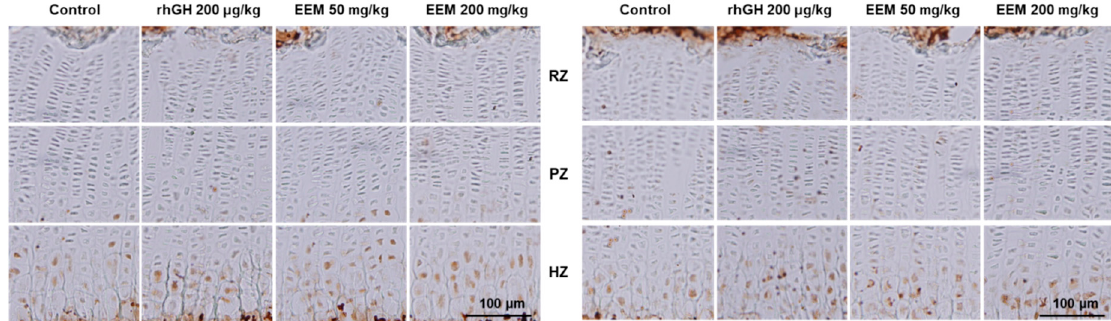
Figure 5. Immunohistochemical localizations of IGF1 and BMP2 on the proximal tibial GP in rats. RZ: Resting zones, PZ: Proliferative zones, HZ: Hypertrophic zones. Scale bar is 100 µ